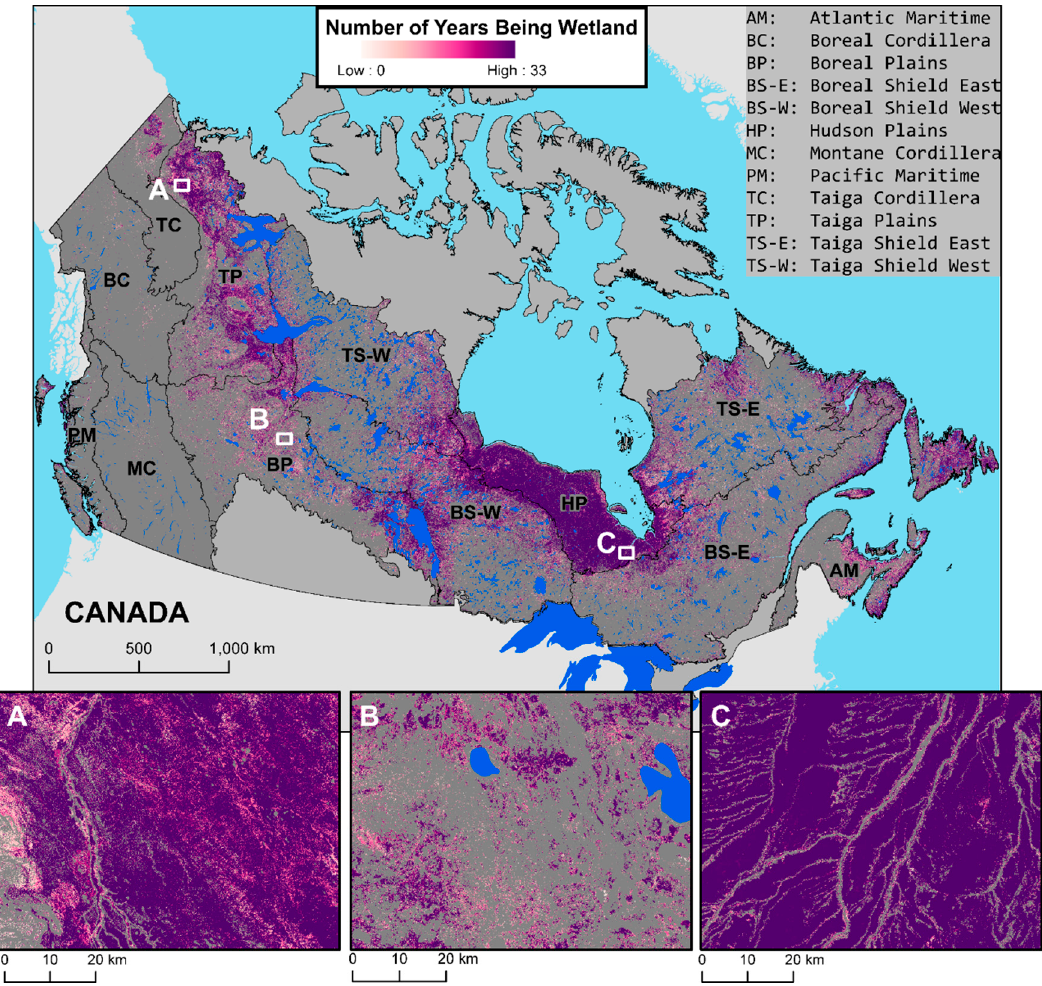
Figure 4. Number of years (maximum 33) that a given pixel was classified as a wetland (treed or non-treed). Grey represents non-wetland. Waterbodies are shown in blue for context.